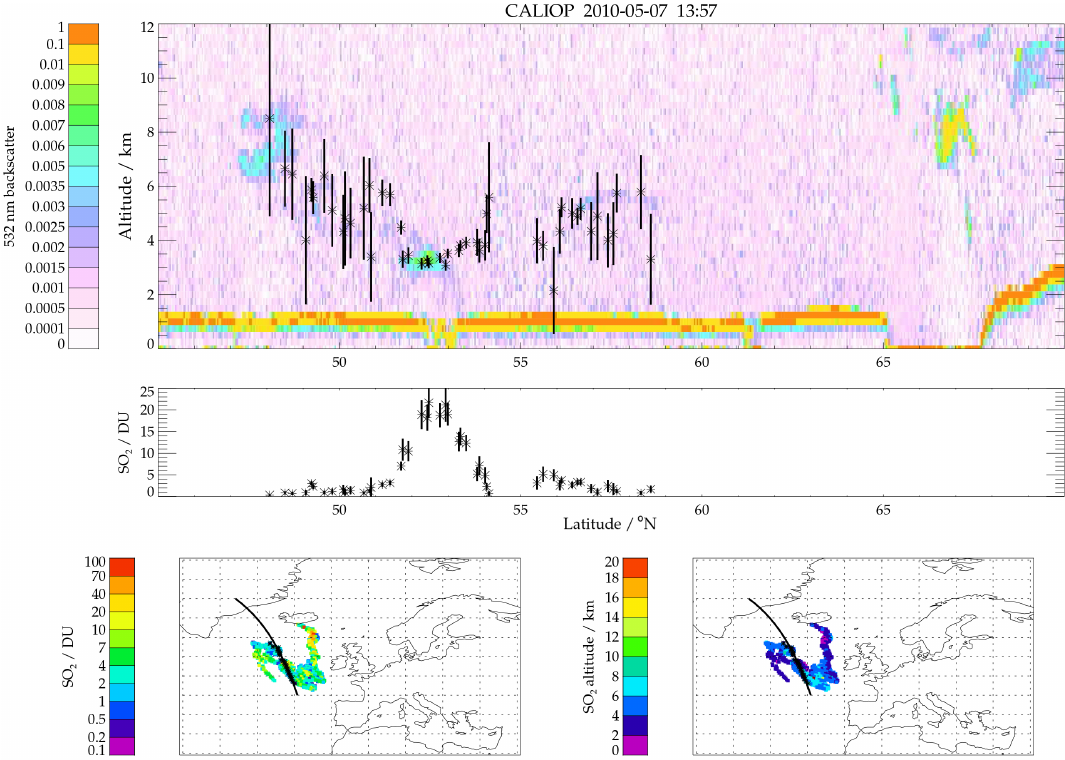
Figure 1. CALIOP/IASI coincidences for the Eyjafjallajökull plume on 7 May 2010 for overpasses within 2h off each other. Top plot: CALIOP backscatter profile with IASI over-plotted retrieval altitude (black stars) and error bar (black line); middle plot: the IASI SO 2 amount and error bars corresponding to the altitude plotted above; bottom plots: map of IASI SO 2 amount (left) and altitude (right) with CALIPSO track (black line) and identifying the IASI pixel plotted above with black